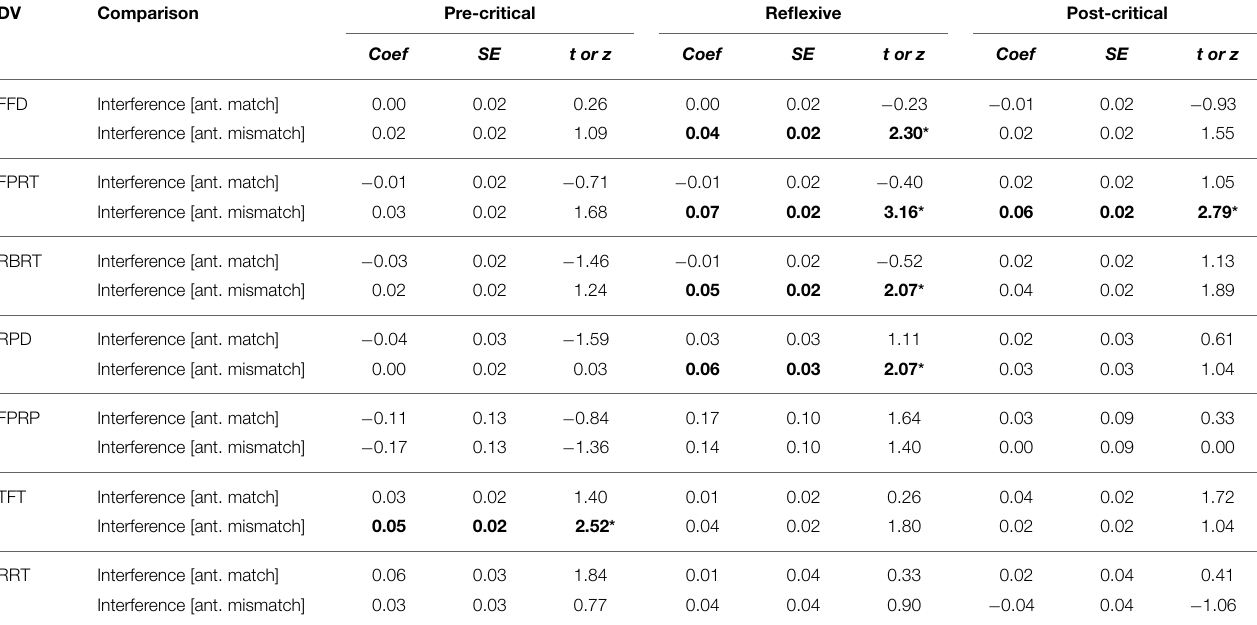
TABLE 5 | Experiment 1: Pairwise comparisons of animacy of the distractor (interference) nested within animate/inanimate antecedent (antecedent match/mismatch) at the pre-critical ( ziji − 1), critical ( ziji ), and post-critical ( ziji + 1) regions for the dependent variables (DVs) first-fixation